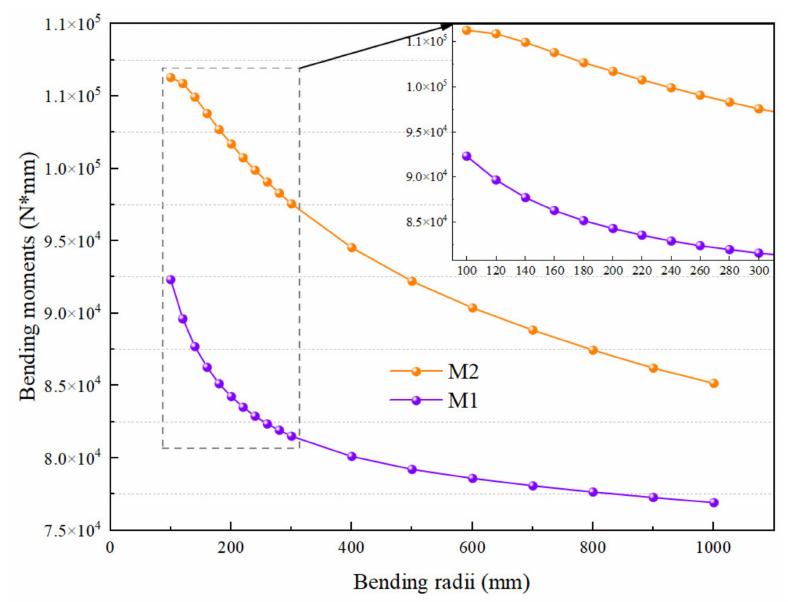
Figure 15. Development trend of bending moment, M 1 and M 2 , with decreasing